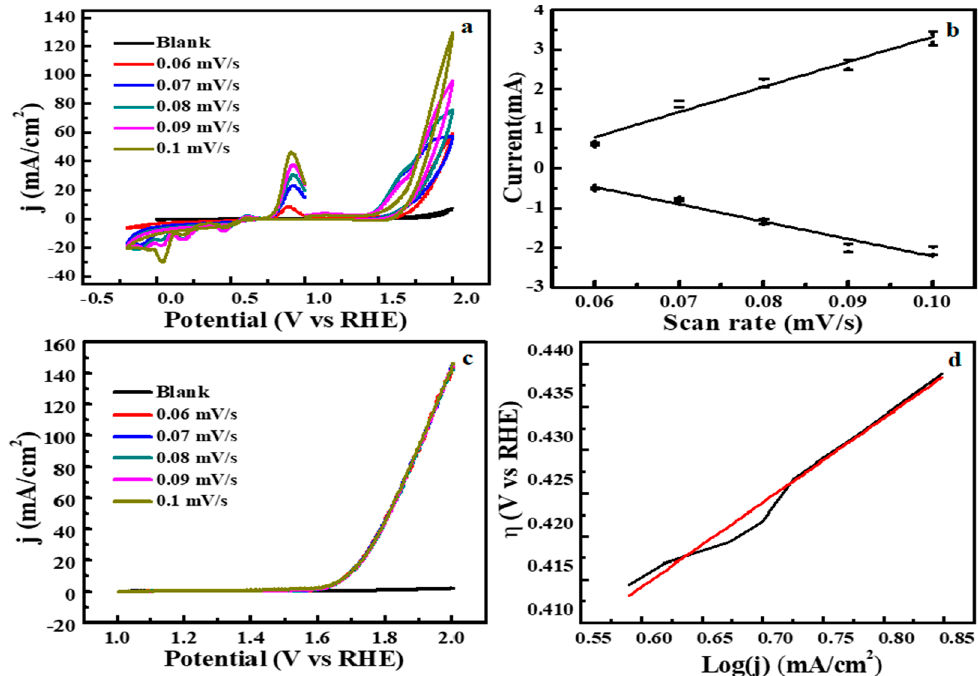
Figure 5. ( a ) LSV curves for Cu 2 O-Co 3 O 4 composite and the ( b ) calibration curve, ( c ) LSV curves, and ( d ) the corresponding Tafel plots for Cu 2 O-Co 3 O 4 composite, in 1 M KOH, at different scan rates.